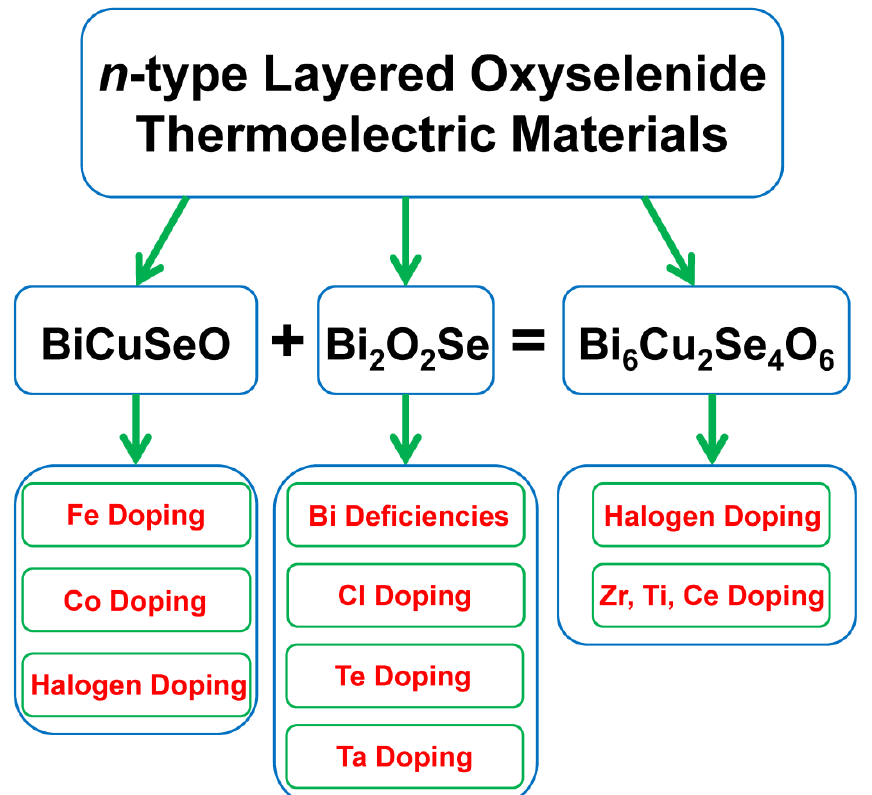
Figure 1. The outline of this review.